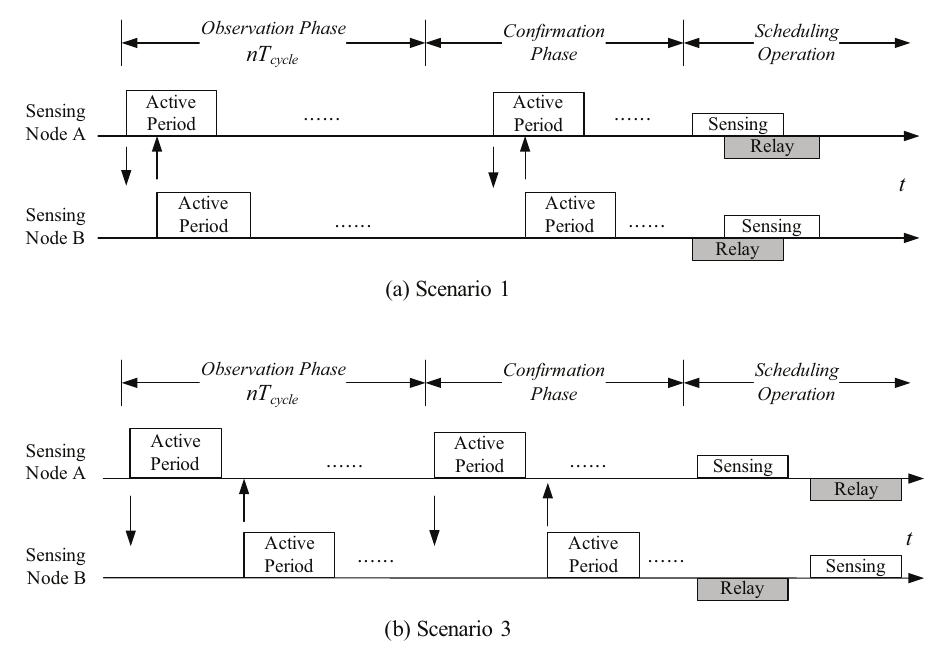
Figure 2. The procedures of selecting a pair of distributed gateways in Scenario 1 (a) and Scenario 3